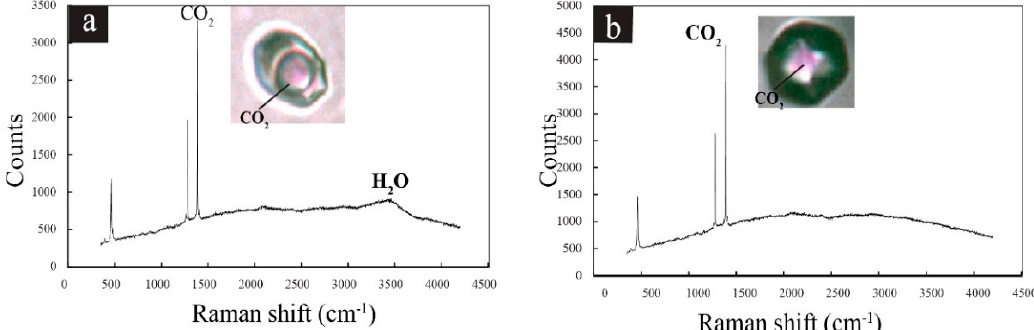
Figure 11. Representative Raman spectra of fluid inclusions in vein quartz associated with hypogene iron ore of the Nabeba deposit. ( a ) H 2 O and CO 2 spectra of the vapor phase in the Type IIIb fluid inclusion in quartz vein A (HO-1 stage); ( b ) CO 2 spectrum of vapor phase in Type I fluid inclusion in quartz vein A (HO-1 stage).